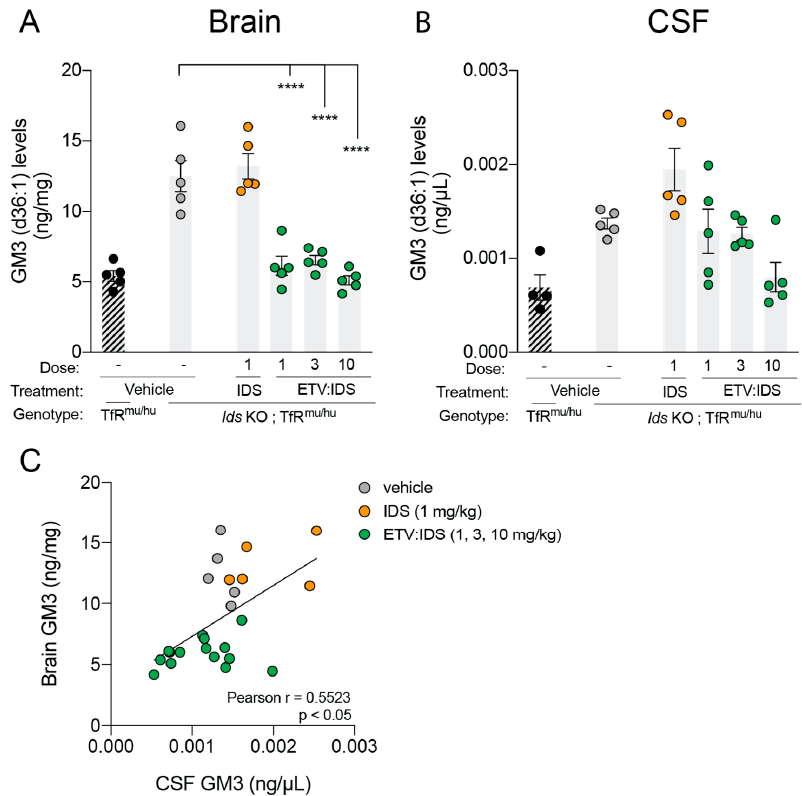
Figure 2. Correlation between brain and CSF gangliosides (GM3) in Ids KO;TfR mu/hu KI mice. Ganglioside GM3 levels were evaluated in brain and CSF of Ids KO;TfR mu/hu KI mice treated with IDS or increasing doses of ETV:IDS. TfR mu/hu KI mice served as non-disease controls. Brains ( A ) and CSF ( B ) were harvested 7 days following the last dose, and ganglioside levels were measured using LC-MS/MS; ( C ) a scatter plot was used to show the correlation between brain and CSF ganglioside levels of Ids KO;TfR mu/hu KI treated with ETV:IDS. Pearson r was used to determine the correlation coefficient. Graphs display mean ± SEM and p values: one-way ANOVA with Dunnett multiple-comparison test;